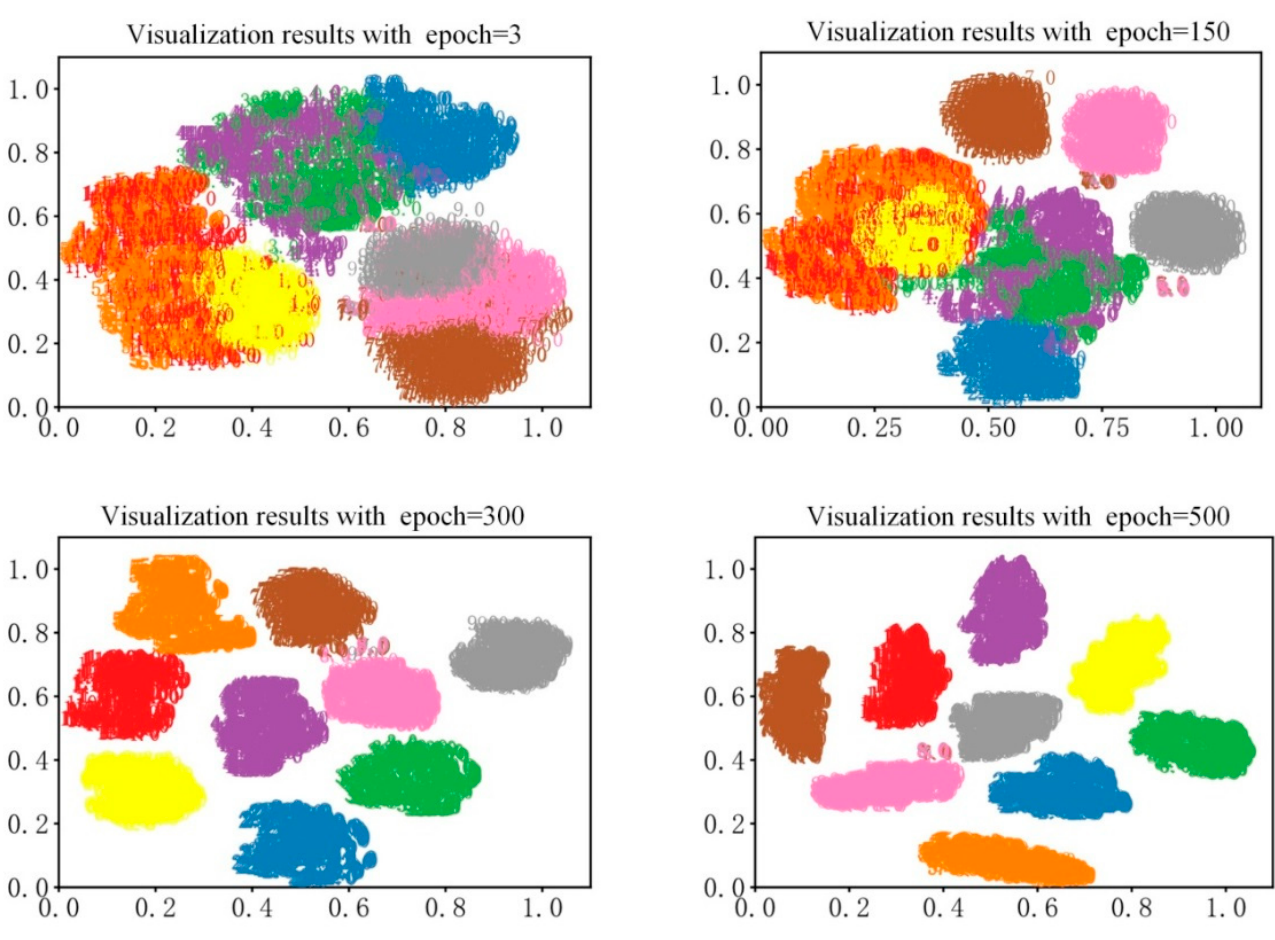
Figure 7. Visualization results of BICNN.